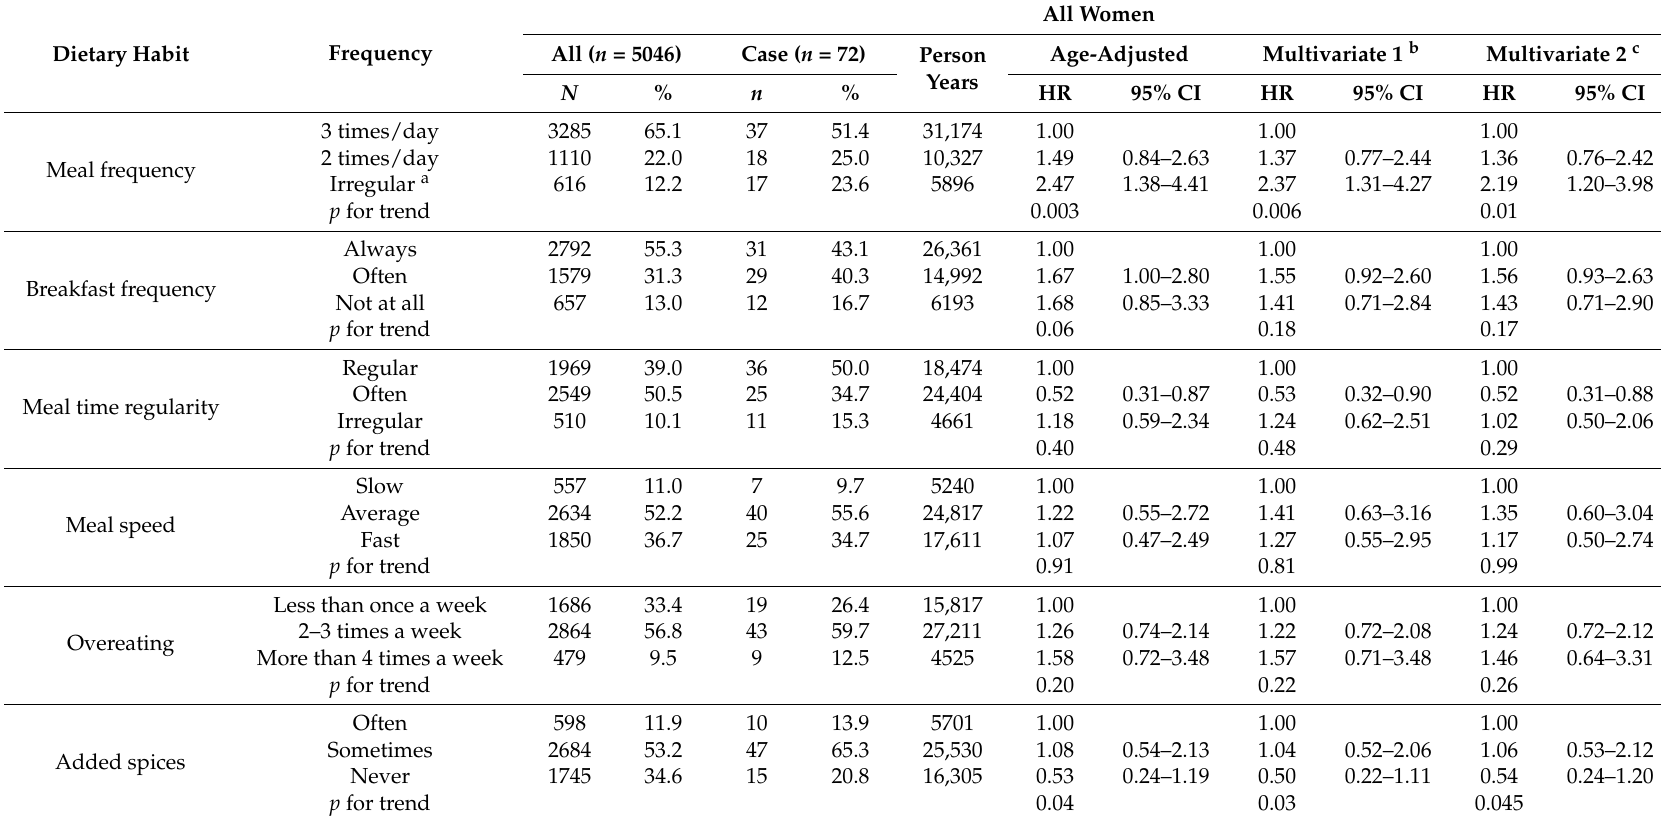
Table 5. Six dietary habits and their associations with breast cancer risk in all